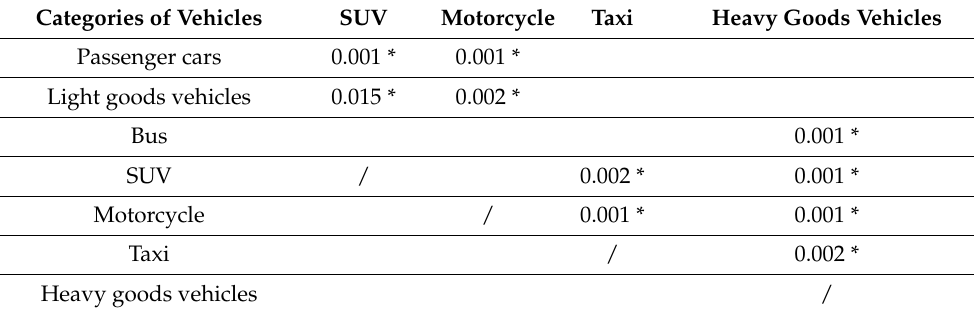
Figure 4. Average lateral distance when overtaking an e-bicycle according to vehicle categories. Table 2. Statistically significant results for lateral distance when overtaking an e-bicycle according to vehicle categories.